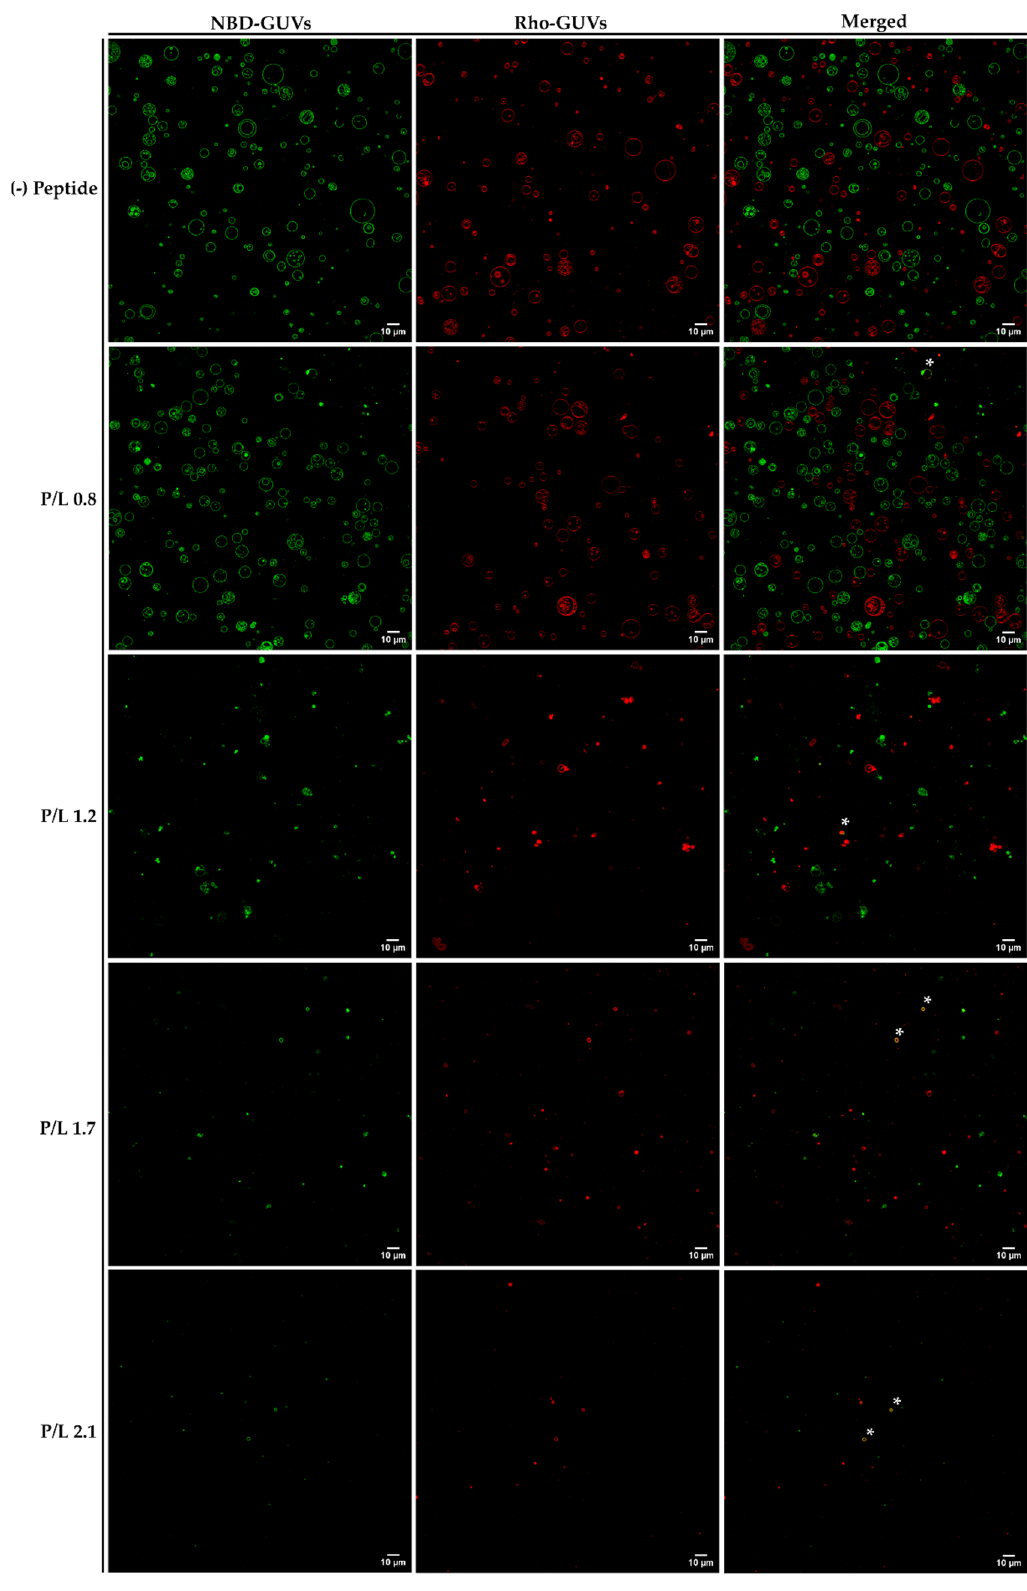
Figure 11. Fusion of the POPC:POPG (1:1) GUVs in the presence of W-BP100 by confocal microscopy. Representative images of a mixture of 2% NBD- and 0.1% Rho-labelled GUVs (1:1 molar ratio) in the absence ( − ) and presence of peptide (P/L of 0.8, 1.2, 1.7 and 2.1) . Fusion events are highlighted with asterisks (*). Magnification: 630×. Scale bar: 10 µm.